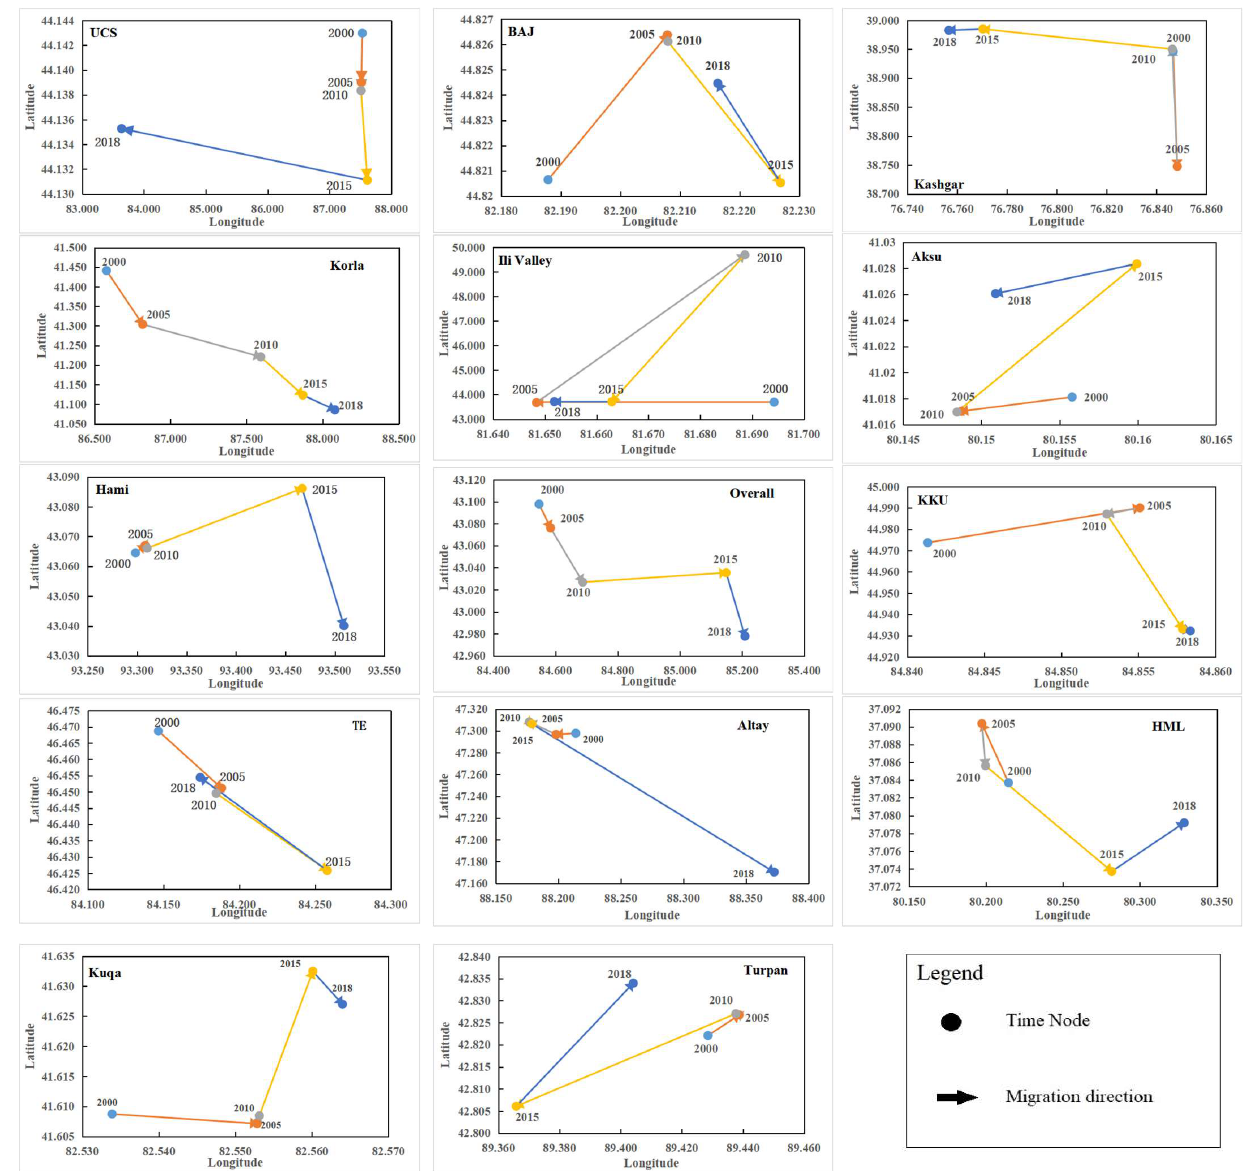
Figure 3. Distribution shifts of the centers of gravity of construction land in 13 town groups from 2000 to 2018.